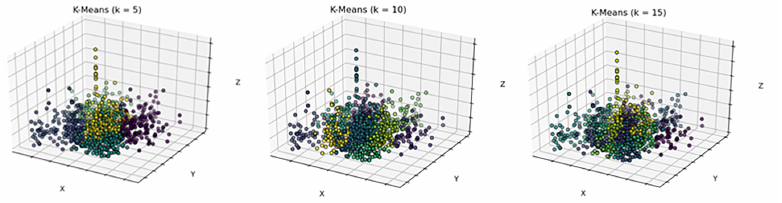
Figure 6. The first clustering results of three-dimensional descriptors with different initial k. From left to right are the clustering results of k = 5, k = 10, and k = 15, respectively.